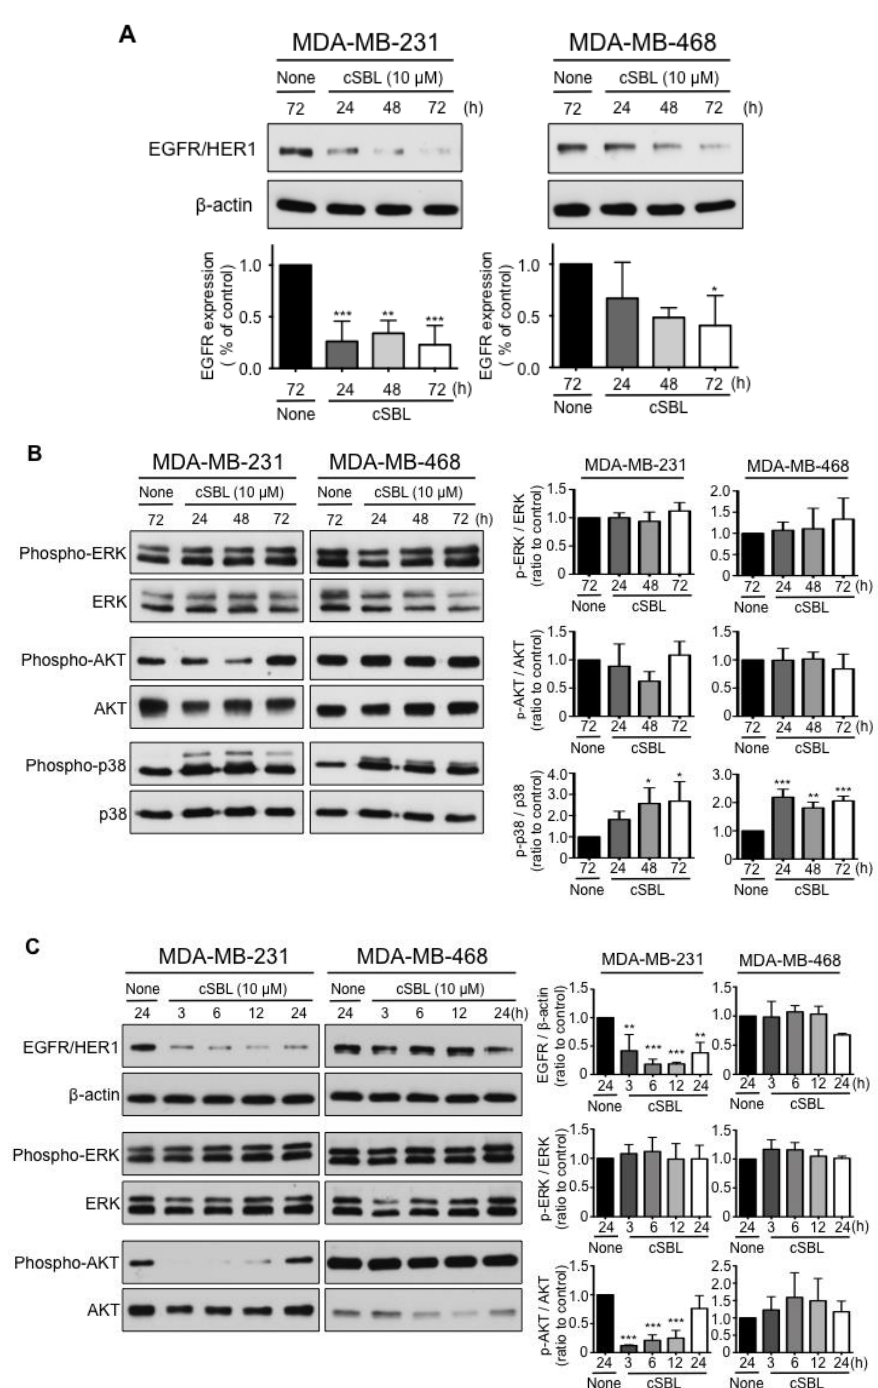
Figure 5. Effects of cSBL on EGFR/HER1 expression and downstream signaling in MDA-MB-231 and MDA-MB-468 cells. ( A ) Cells were treated with cSBL (10 µM) for 24 to 72 h, and the expression levels of EGFR/HER1 in each cell line were detected by western blotting. Densitometric quantification